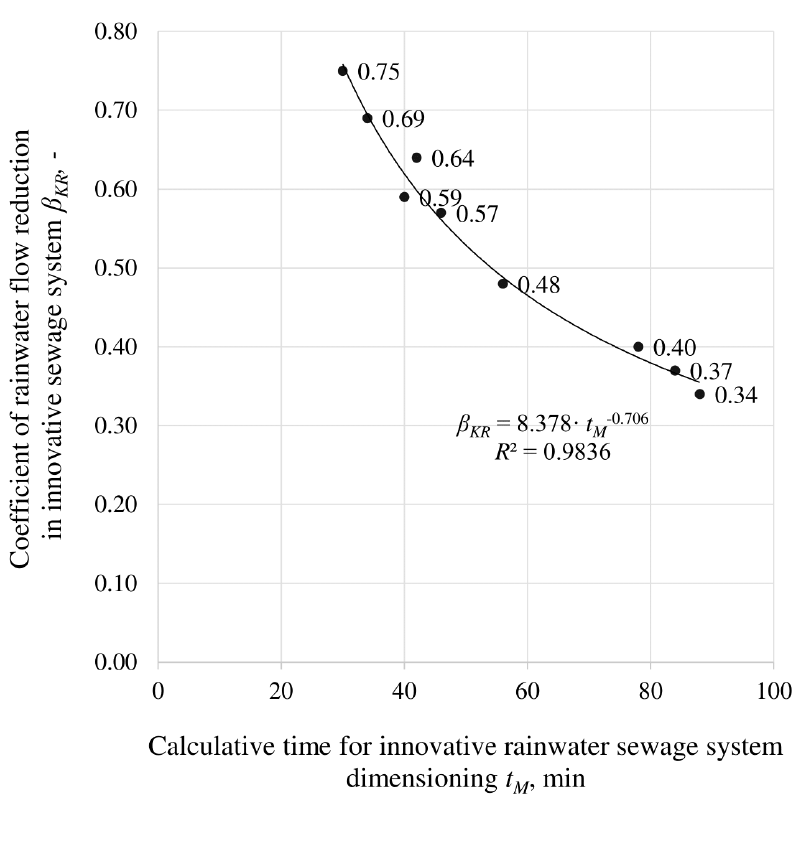
and the critical time t (based on KR M